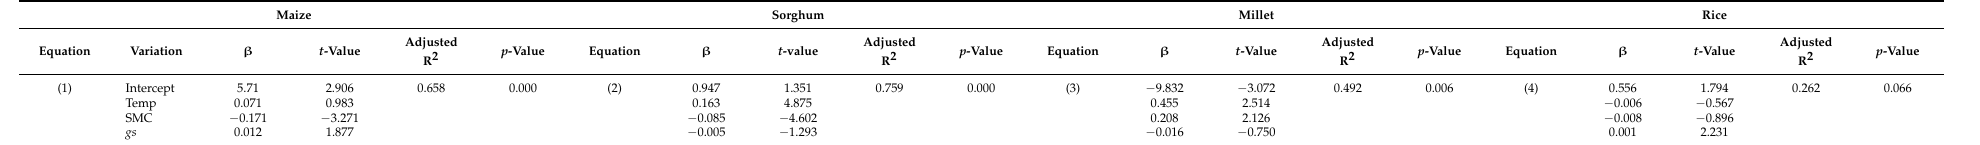
Table 2. The multiple linear regression for shoot biomass (g plant − 1 ) based on parameters of temperature (Temp), soil moisture content (SMC), and stomatal conductance ( gs ) under three soil moisture regimes (MSM, GSD, CSW) and two temperatures (24/15 ◦ C and 34/25 ◦ C) ( n = 18). Maize Sorghum Millet